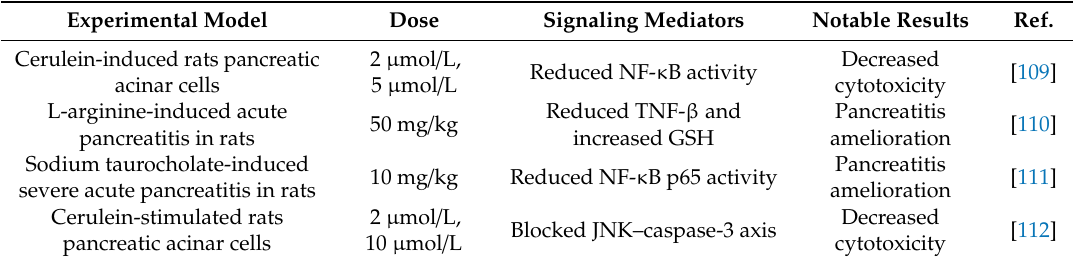
Table 2. The e ff ect of lycopene on signaling pathways in pancreatitis